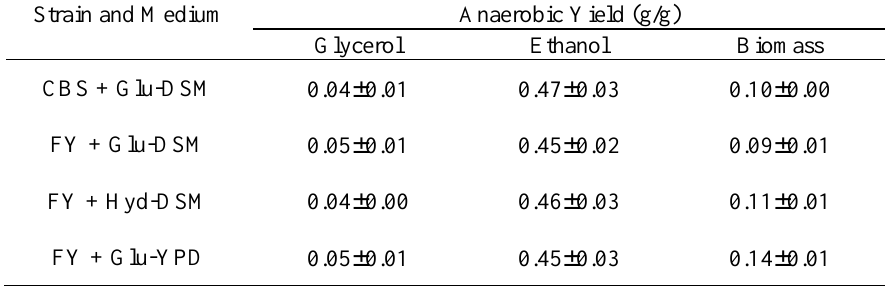
Table 1 . Yields (g/g consumed fermentable sugar) of glycerol, ethanol and biomass in anaerobic batch cultivations of the flocculating yeast (FY) and lab strain (CBS) on glucose and hydrolyzate in defined synthetic (DSM) and YPD media. The results were taken after 48 h of